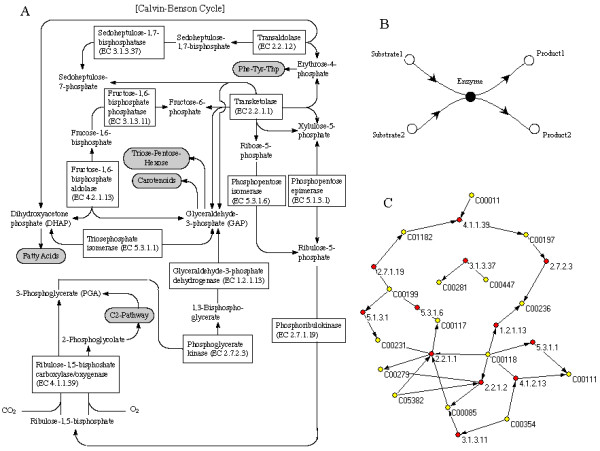
The Calvin Cycle pathway and its hypergraph representation.(A) The metabolic scheme of the Calvin Cycle, derived from the Database of Chloroplast/Photosynthesis Related Genes. (B) An example of hypergraph representation of biochemical reactions. (C) Graph visualization of the Calvin Cycle pathway in (A), where the red nodes and yellow nodes represent enzymes and compounds respectively. ATP, ADP, H2O, H+, NAD+, NADP+, NADH, NADPH, Orthophosphate and Pyrophosphate have been omitted.